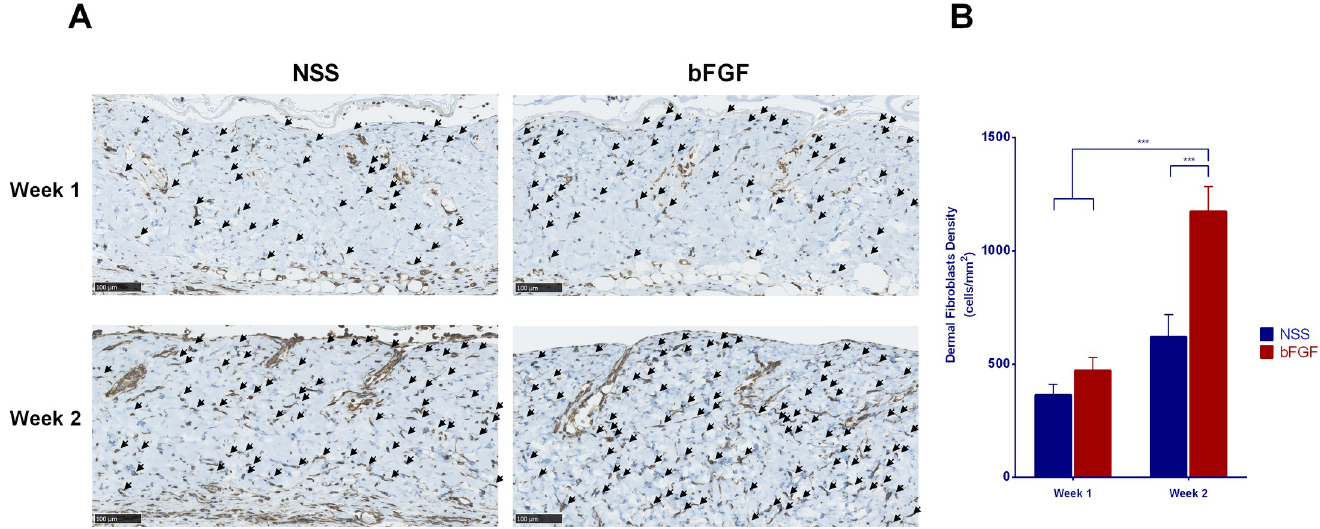
Fig 3. The infiltration of recipient fibroblasts into inactivated dermis after implantation. (A) Micrographs of anti-vimentin-stained sections differentiating fibroblasts from other cells at Weeks 1 and 2 after implantation. Recipient fibroblasts began to infiltrate the grafts at Week 1 and increased at Week 2. . : fibroblast; magnification: 20x, scale bar: 100 μ m. (B) A comparison of the dermal fibroblast density of the grafts; a significant increase in the number of fibroblasts in the bFGF group was noted between Weeks 1 and 2 as well as between the bFGF and NSS groups in Week 2 ( ��� p < 0.001).